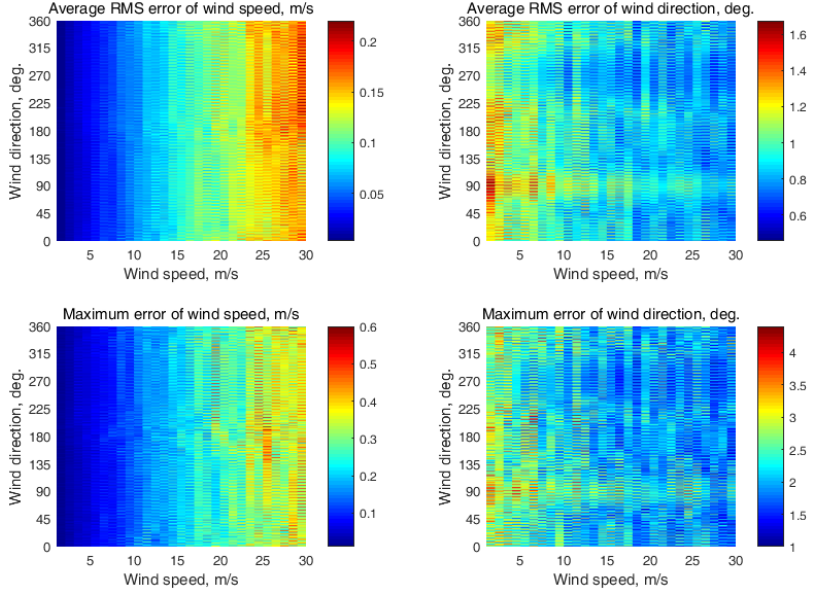
Figure A9. Semicircular wind retrieval results at the (30°, 35°) incidence angle combination.